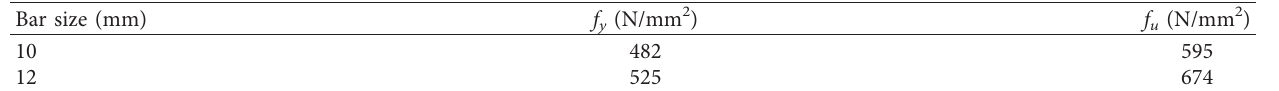
Figure 2: Natural coarse and recycled aggregate grading curves. Table 5: Characteristics of reinforcing bars.